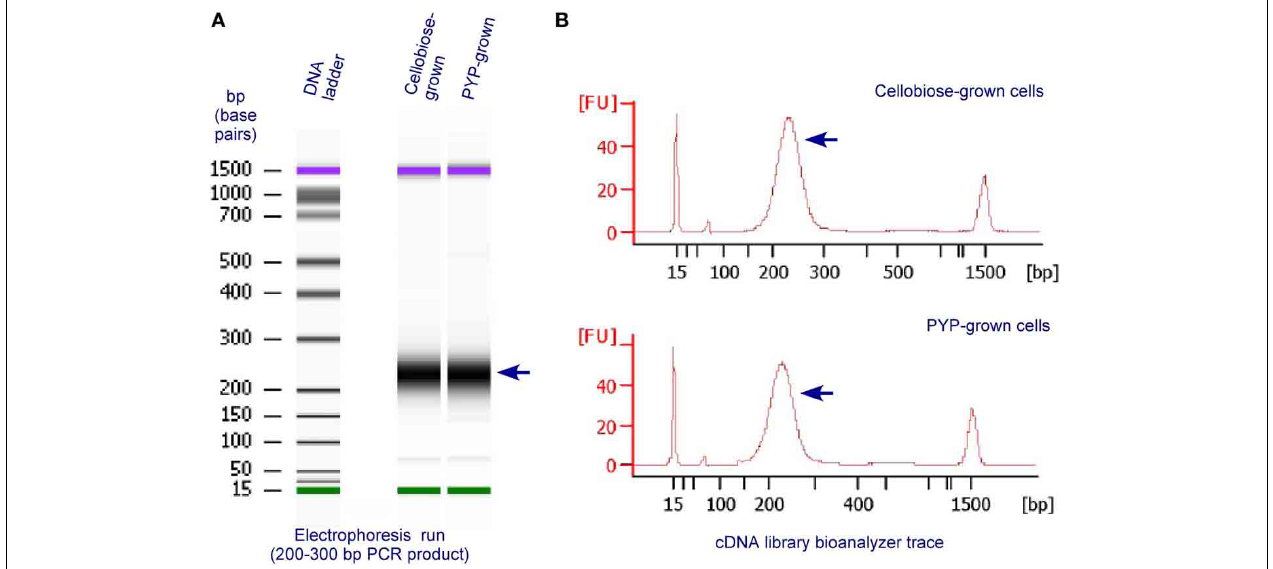
FIGURE 2 | Validation and quantification of representative, final RNA-Seq cDNA libraries prior to GA II, using an Agilent 2100 Bioanalyzer and the DNA 1000 Nano Chip Kit (Agilent, Technologies, Santa Clara, CA,